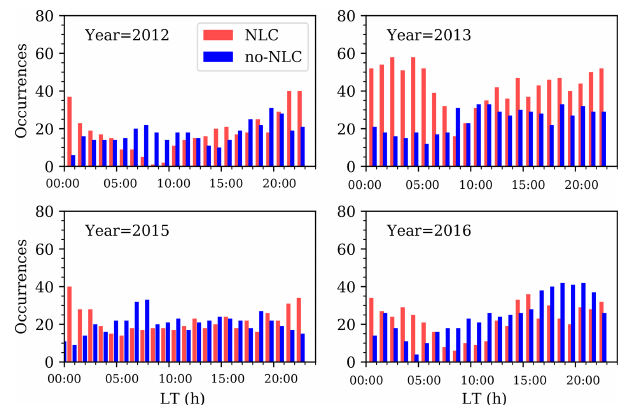
Figure 5. NLC and non-NLC occurrences (number of 15min inter- vals) over local time during the observation years from Andenes are shown. Similar figures for other stations are shown in Supplement Fig. S1. These samplings show that though the NLC and non-NLC occurrence and sampling are not uniform over local-time hours they do not vary significantly, except in the year 2013 where a diurnal- tide-like variability may be recognized.